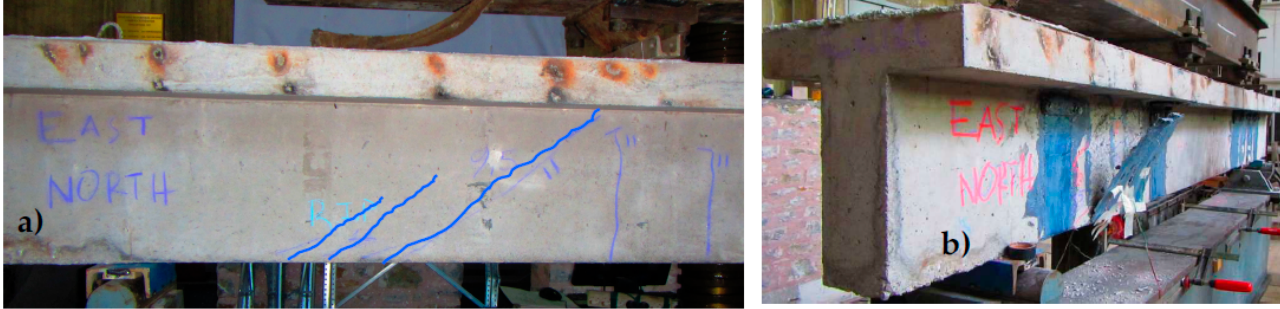
Figure 17. Comparison of failure modes between the prototype RC Virgin T-beam and this T-beam having been retrofitted with the 1st strengthening scheme. ( a ) Diagonal shear cracks at the East part of the Virgin T-beam. ( b ) The debonding of two open hoop CFRP strips without anchoring at the East part of this T-beam retrofitted with the 1 st st rengthening scheme .